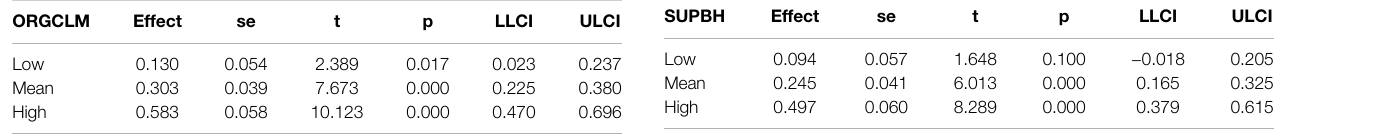
TABLE 3 | Conditional effects of the focal predictor at values of the moderator(s). ORGCLM